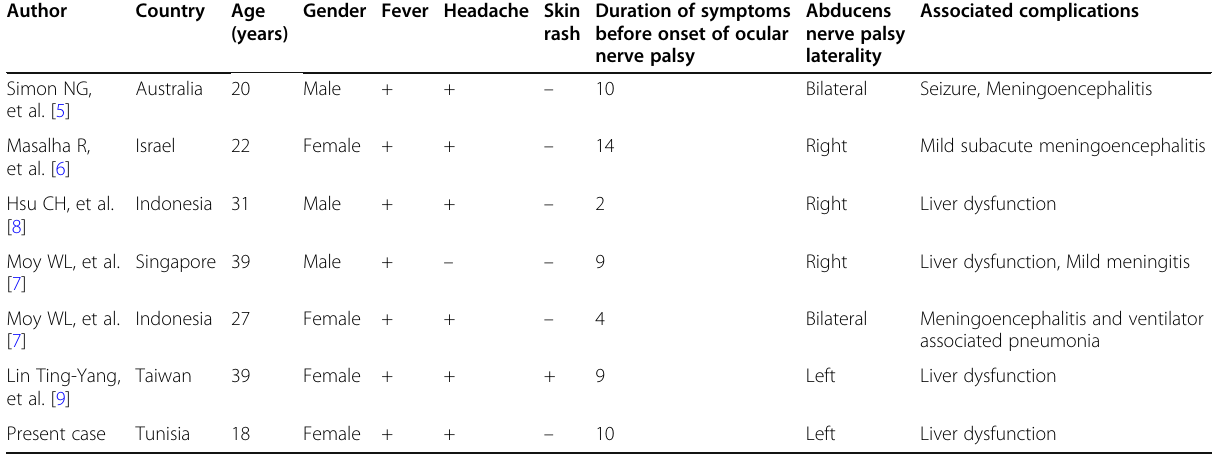
Table 1 Reported cases of murine typhus related abducens nerve